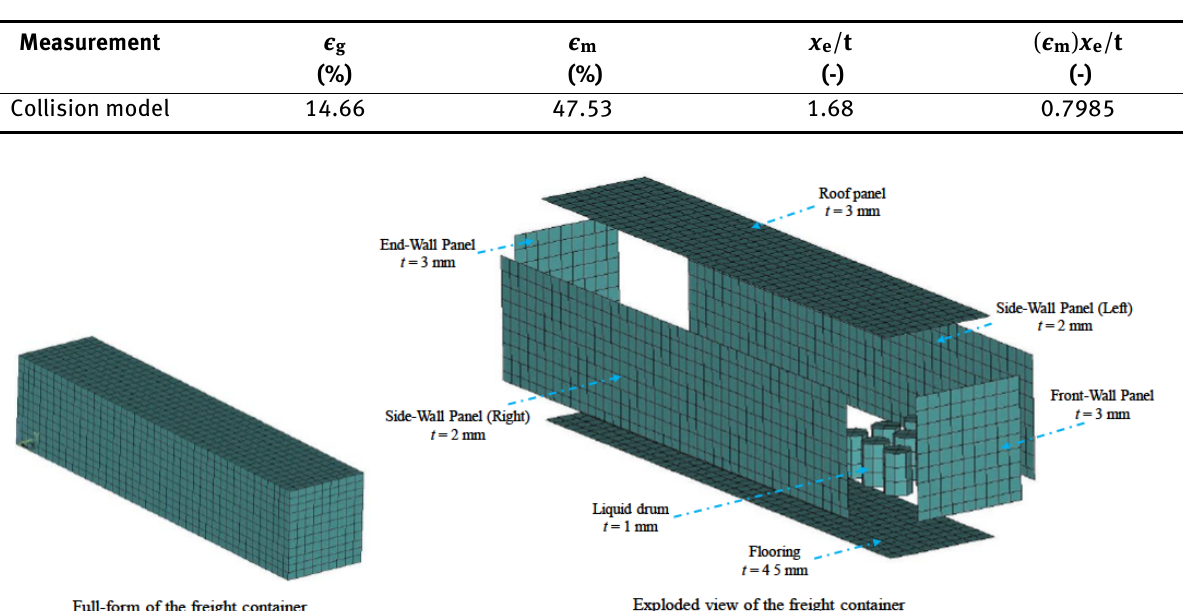
Table 6: Result of the thickness measurement for Peschmann-Lehman criterion